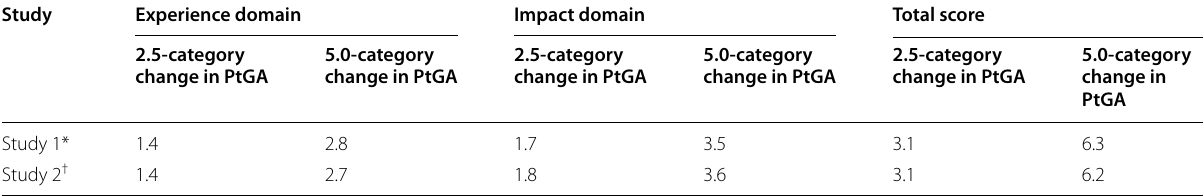
FACIT-F, Functional Assessment of Chronic Illness Therapy-Fatigue; MWPC, meaningful within-patient change; PtGA, Patient Global Assessment of Disease Activity *NCT01786668 (phase 2 study) † NCT03502616 (phase 3